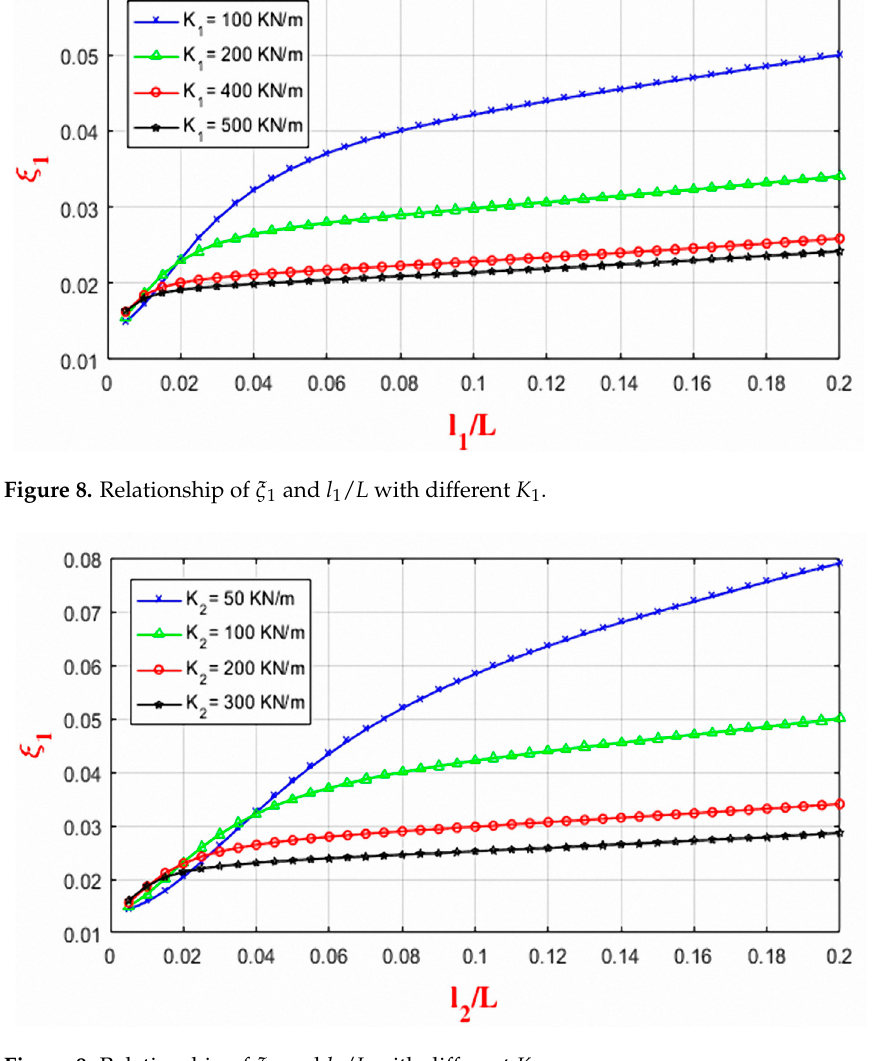
Figure 9. Relationship of ξ 1 and l 2 / L with different K 2 .